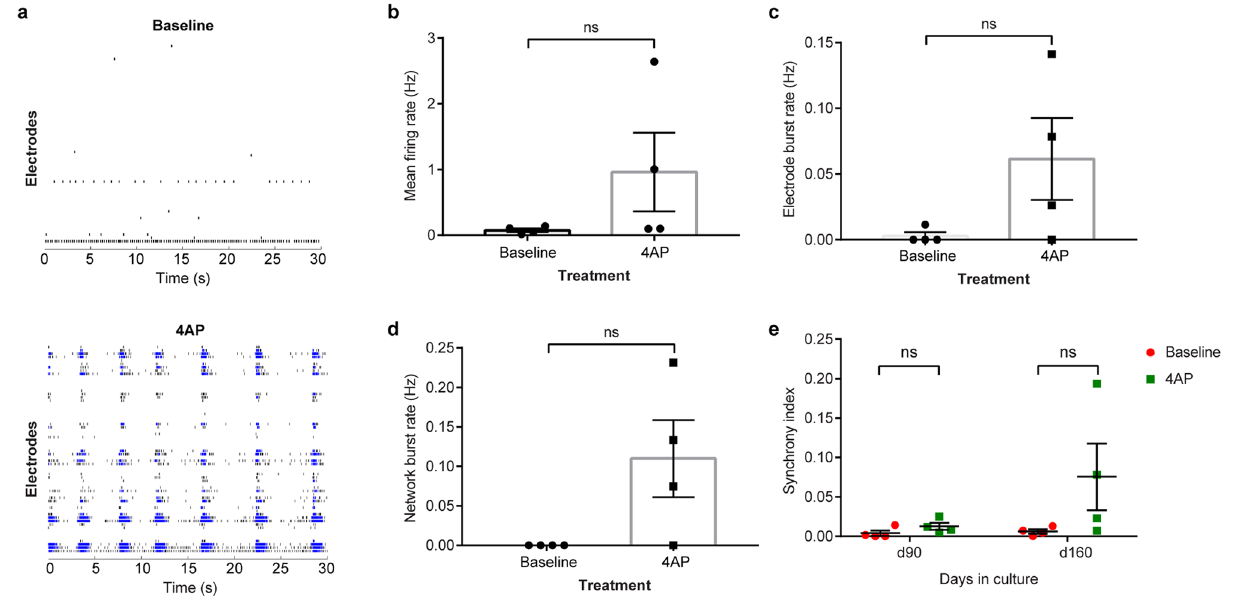
Figure 4. Effect of 4AP on neuronal activity in 160-day-old cerebral spheroids. ( a ) Representative raster plots of a 160-day-old cerebral spheroids before (upper) and after exposure (lower) to 4AP. Exposure to 4AP triggered network bursts characterized by synchronous bursting of several electrodes. Black marks indicate individual spikes while blue marks indicate electrode bursts. ( b ) Mean firing rate in spheroids before and after exposure to 4AP. Paired Student’s t -test, p = 0.2327. Bars represent mean ± SEM. Each dot represents an individual spheroid, n = 4 spheroids/condition ns: not significant. ( c ) Electrode burst frequency in spheroids before